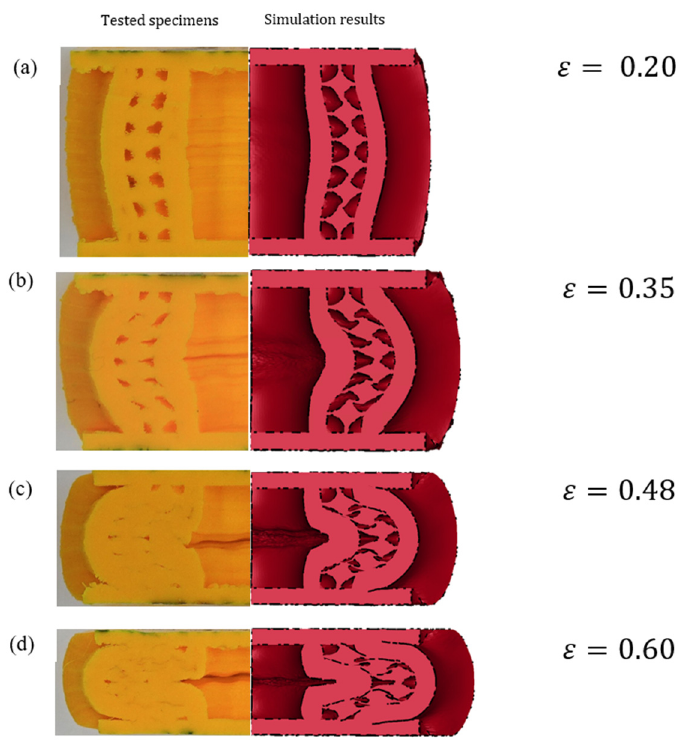
Figure 14. Experimental and simulated failure mechanisms at different strain levels during com- = 0.20, ( b ) ε = 0.35, ( c ) ε = 0.48, and ( d ) ε = pression at ( a ) 𝜀 = 0.20, ( b ) 𝜀 = 0.35, ( c ) 𝜀 = 0.48, and ( d ) 𝜀 = 0.60 . sion at ( a ) ε